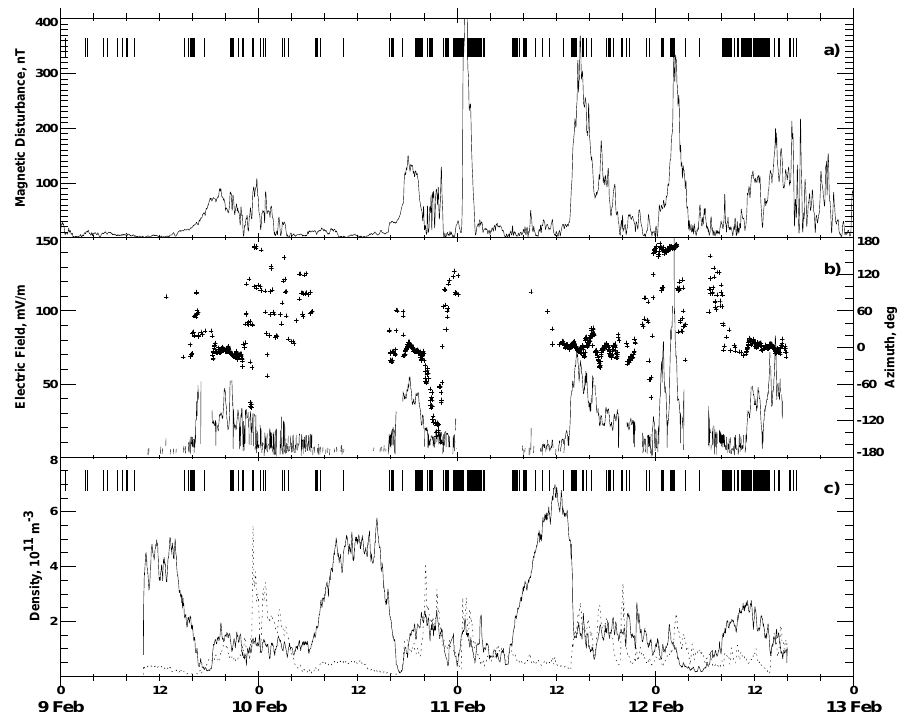
Fig. 3. (a) Horizontal magnetic perturbations at Tromsø, (b) electric field magnitude (solid line) and azimuth (crosses), and (c) electron density at 250 km (solid line) and 110km (dots). Vertical bars in panels (a) and (b) indicate the times of HF echo occurrence in beam 5, bin